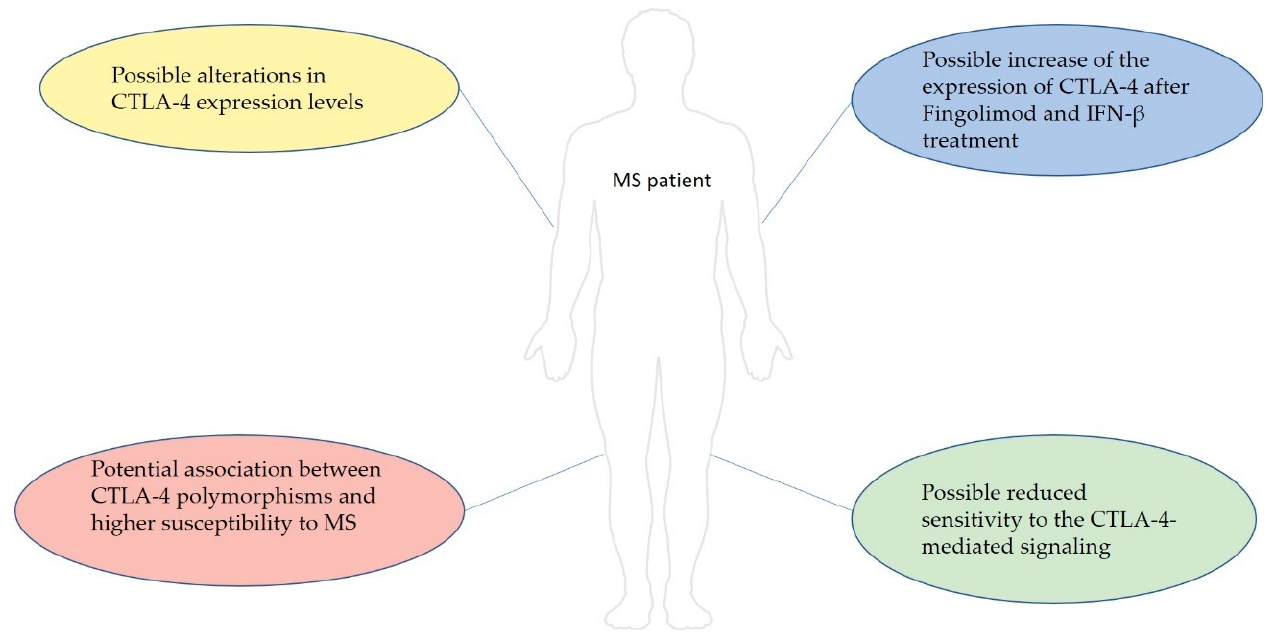
Figure 2. Overview of the main data suggesting a possible role of CTLA-4 in the pathogenesis of MS and its possible involvement in the mechanism of action of common MS therapies. The results show the importance of CTLA-4 levels in the developing of MS, highlighting a general picture where a decreased presence of CTLA-4 might be detrimental for protection from MS. This evidence could be the basis for future therapeutic approaches.